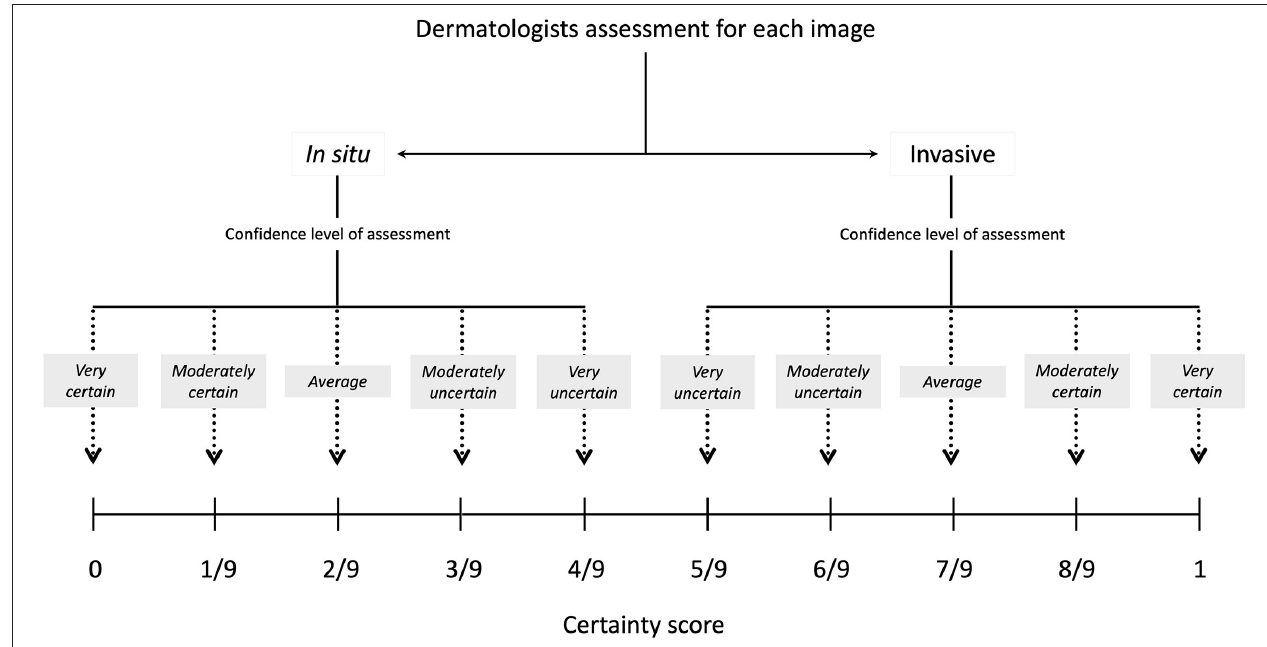
FIGURE 1 | Certainty score. For all image classifications, the dermatologists had to select the degree of certainty. The following scores were available; very certain ( Swe. “mycket säker”), moderately certain ( Swe. “ganska säker”), average ( Swe. “medel”), moderately uncertain ( Swe. “ganska osäker”), and very uncertain ( Swe. “mycket osäker”). The same weights were applied for each step (i.e., for every increasing or decreasing one-ninth) in the scoring system.